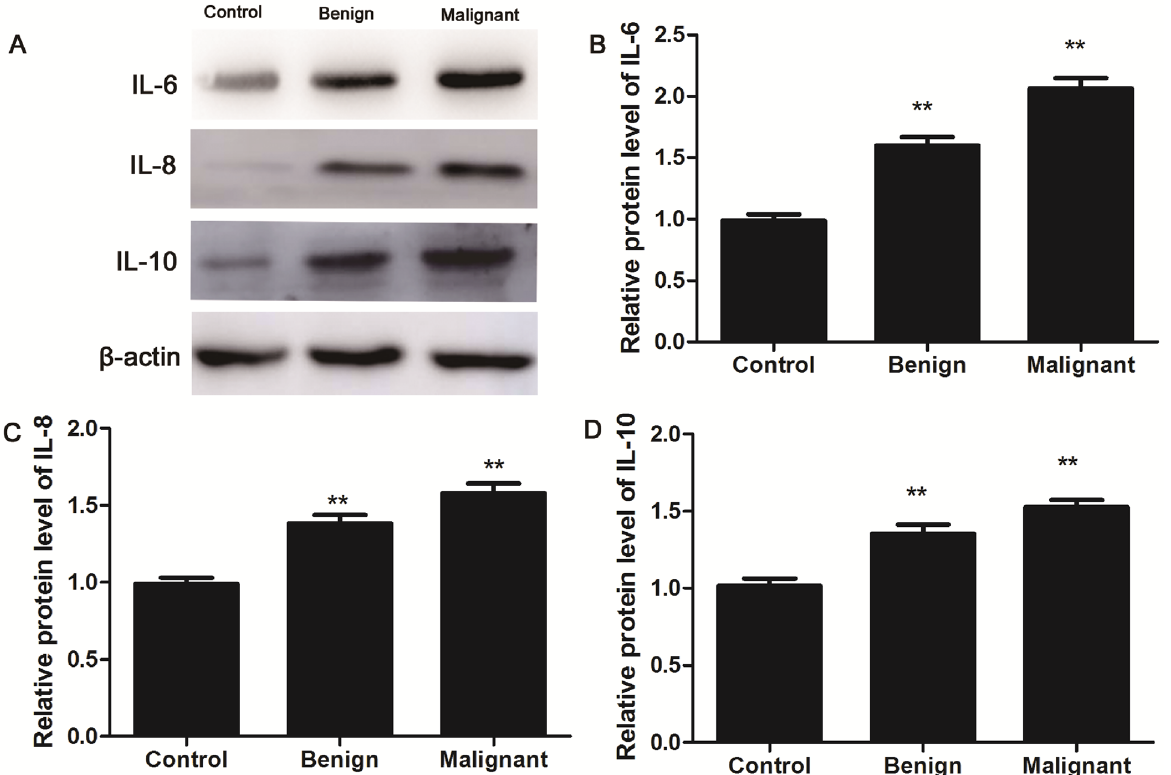
Figure 3. Expression of IL-6, IL-8 and IL-10 proteins in CMGTs and normal canine mammary gland tissues. ( A–D ) The levels of IL-6, IL-8 and IL-10 protein in CMGTs and normal canine mammary gland tissues were estimated by western blot analysis. β-actin was used as loading control. Uncropped images for Western blots are presented in Supplementary Fig. S1. Relative protein levels were quantified using ImageJ 1.48 software. Immunoblots were captured to calculate the normalized values presented in the graph by estimation of express levels from IL-6, IL-8 and IL-10 proteins relative to β-actin protein. Data are presented as mean ± SD of triplicate experiments. *denotes P < 0.05 and ** P < 0.01 compared with the healthy canine mammary gland tissues